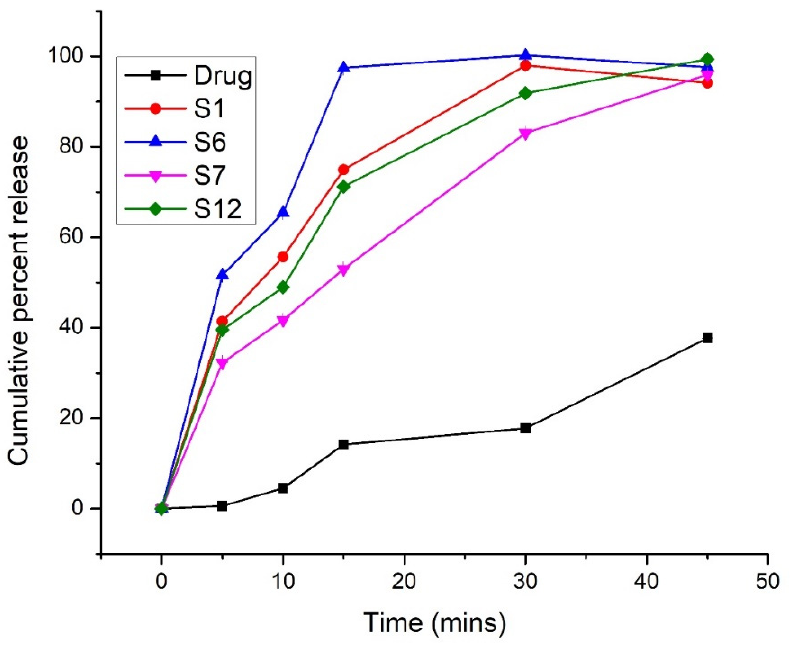
Figure 5. Dissolution profile at pH 6.8 (PBS).